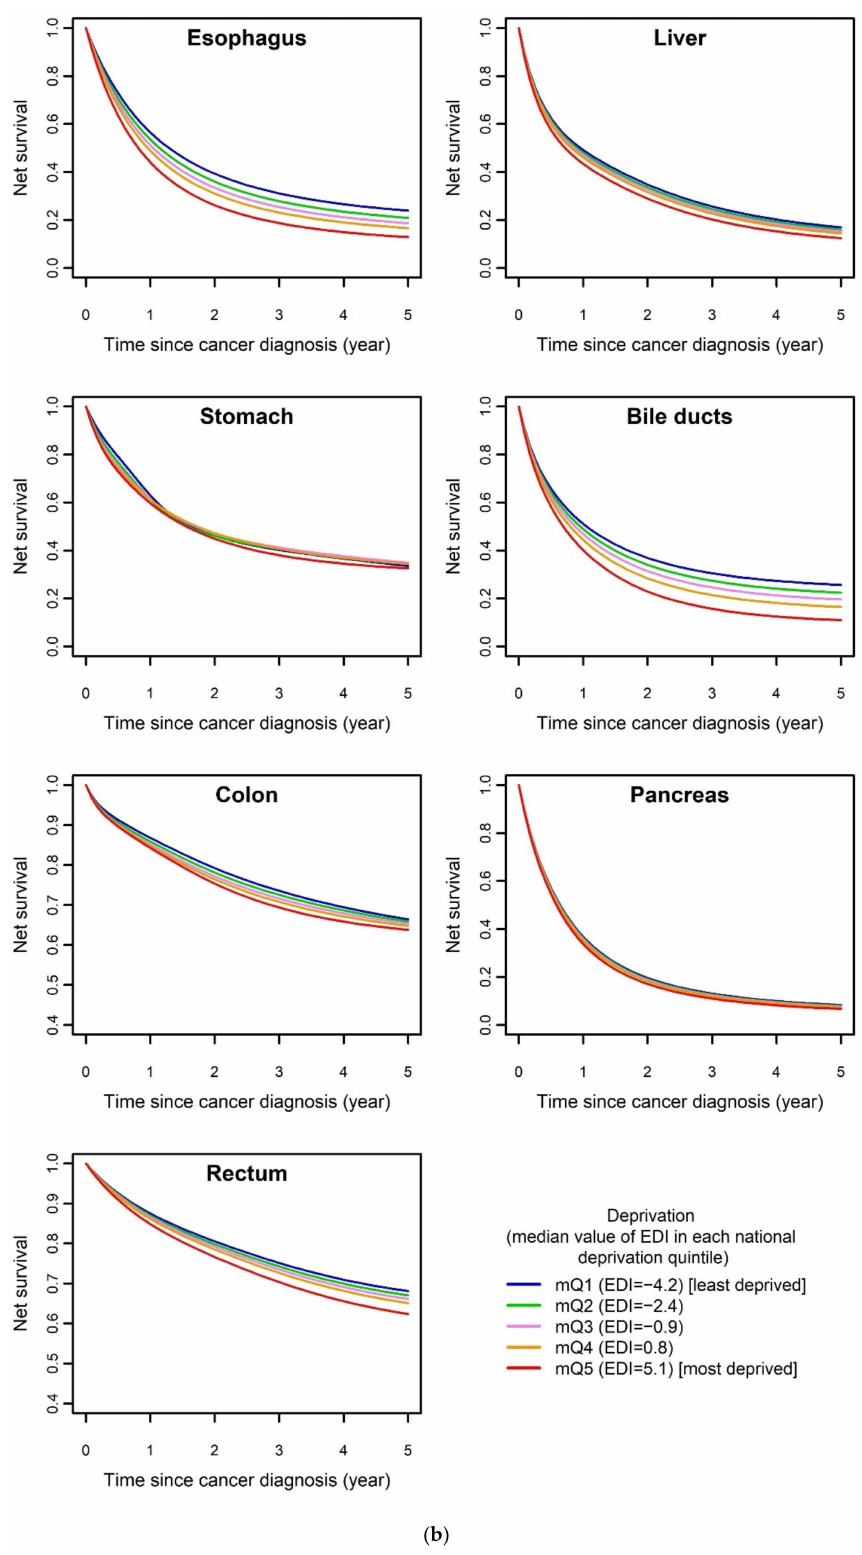
Figure 1. Net survival over time since diagnosis by level of deprivation for each cancer site for which EDI effect was significant, predicted by selected model for 70-year-old ( a ) males and ( b ) females. EDI: European Deprivation Index; mQi : median value of national deprivation quintile i (see Section